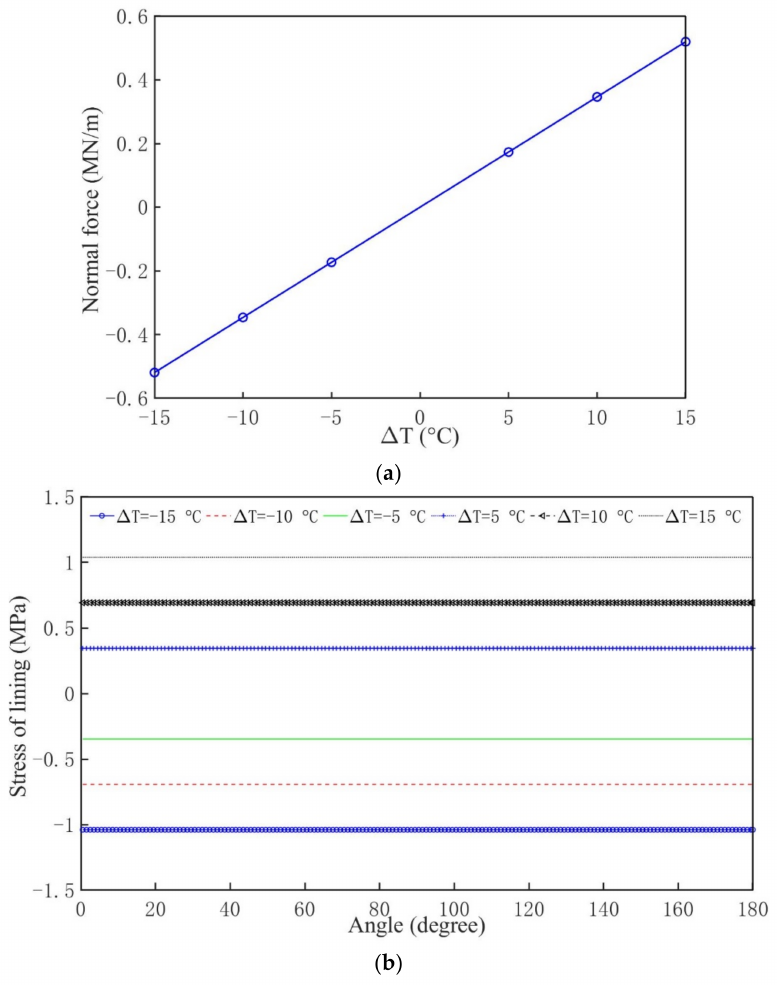
Figure 4. Effect of ∆ T on the internal forces of tunnel lining when only considering σ Tl : ( a ) Normal force; ( b ) Stress of